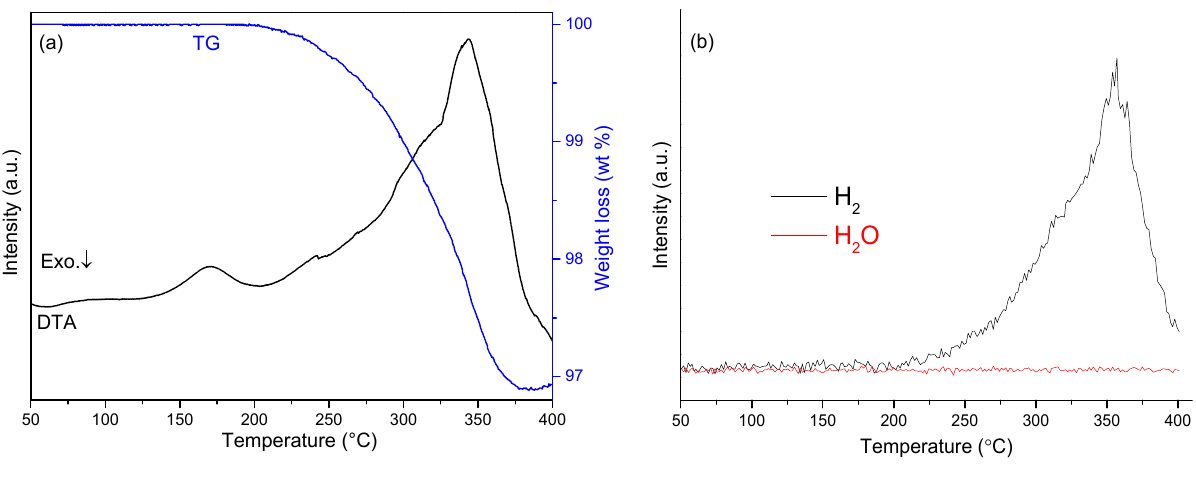
Figure 6. Simultaneous TG-DTA-MS profiles of sample 5: ( a ) TG-DTA traces; ( b ) mass spectra for hydrogen and